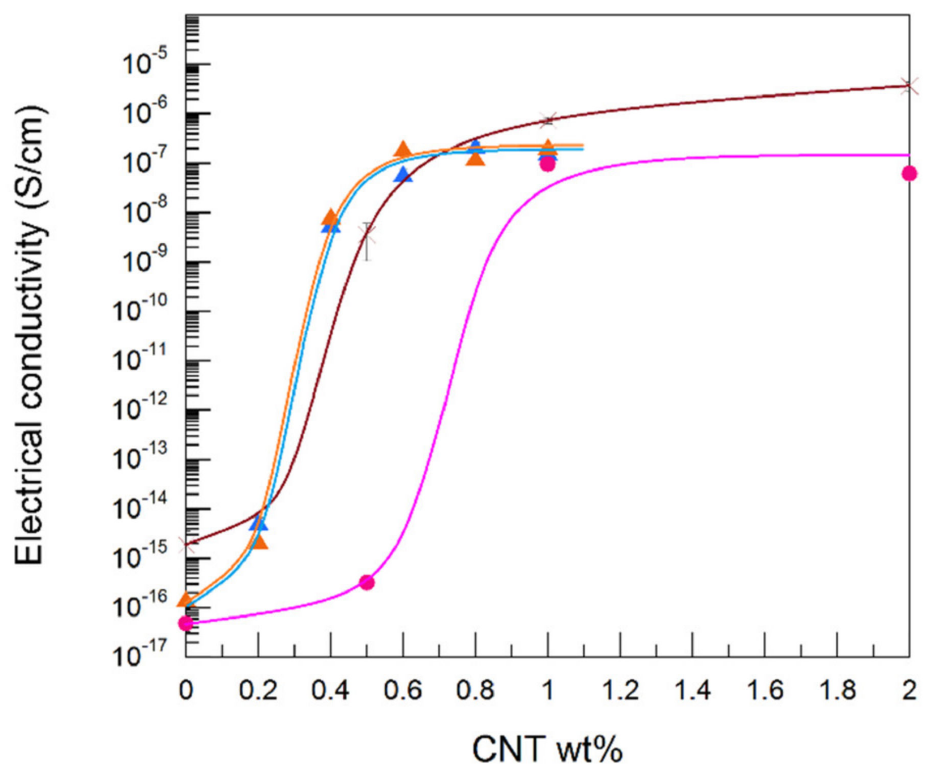
Figure 8. Electrical conductivity of PA410/Pebax/CNT ( (cid:78) ) and PA410/PA6/Pebax/CNT ( (cid:78) ) NCs vs. the CNT content. PA410/CNT (x) and PA410/PA6/CNT ( • ) systems have been represented as a reference [1]. Table 5. Electrical percolation concentration values of PA410/Pebax/CNT,